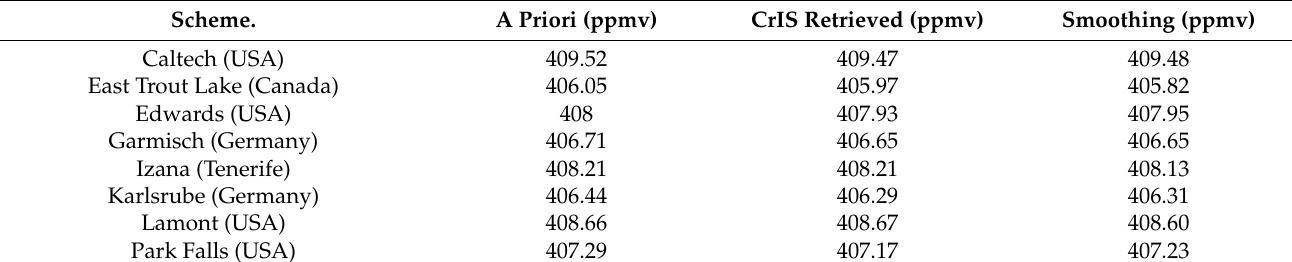
Table 3. Average of XCO 2 comparisons between the a priori, CrIS retrieval, and smoothing TCCON results. Scheme.